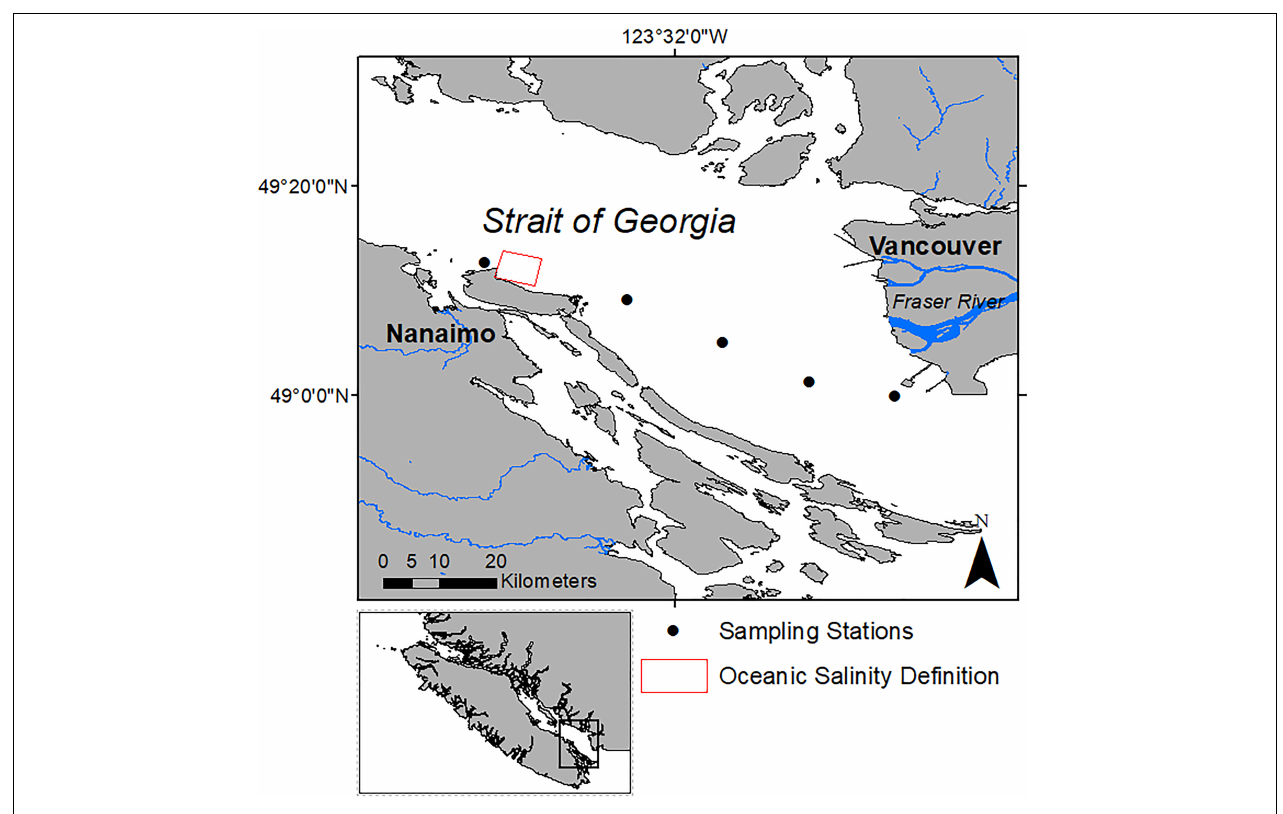
FIGURE 1 | Study area in the Strait of Georgia, British Columbia, Canada. The solid circles indicate the approximate sampling locations of the HPLC measurements along the ferry route between Nanaimo and Vancouver and the solid triangles show the locations of the Duke Point and Tsawwassen ferry terminals in Nanaimo and Vancouver, respectively. The red box indicates the region used to define a salinity threshold to separate oceanic waters and the waters influenced by the Fraser Plume.